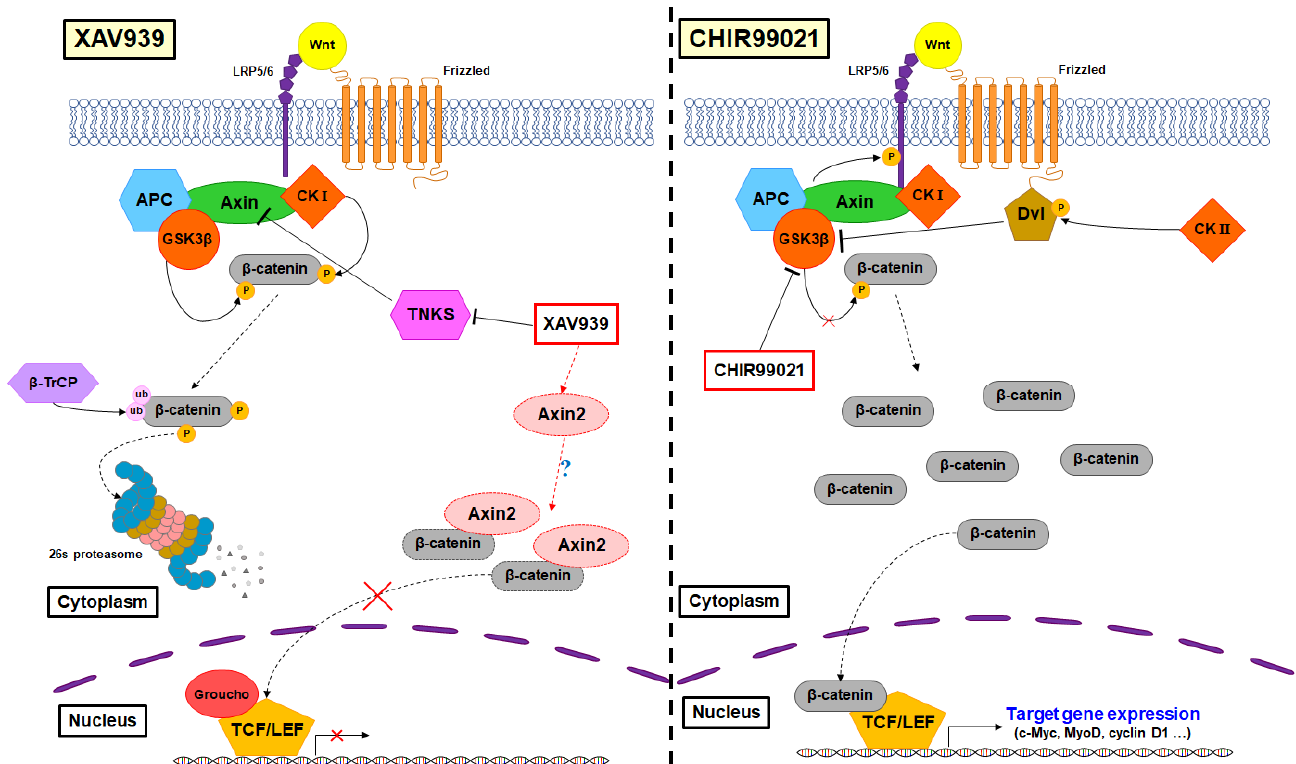
Figure 7. Systematic mechanisms of β -catenin in PMSCs.